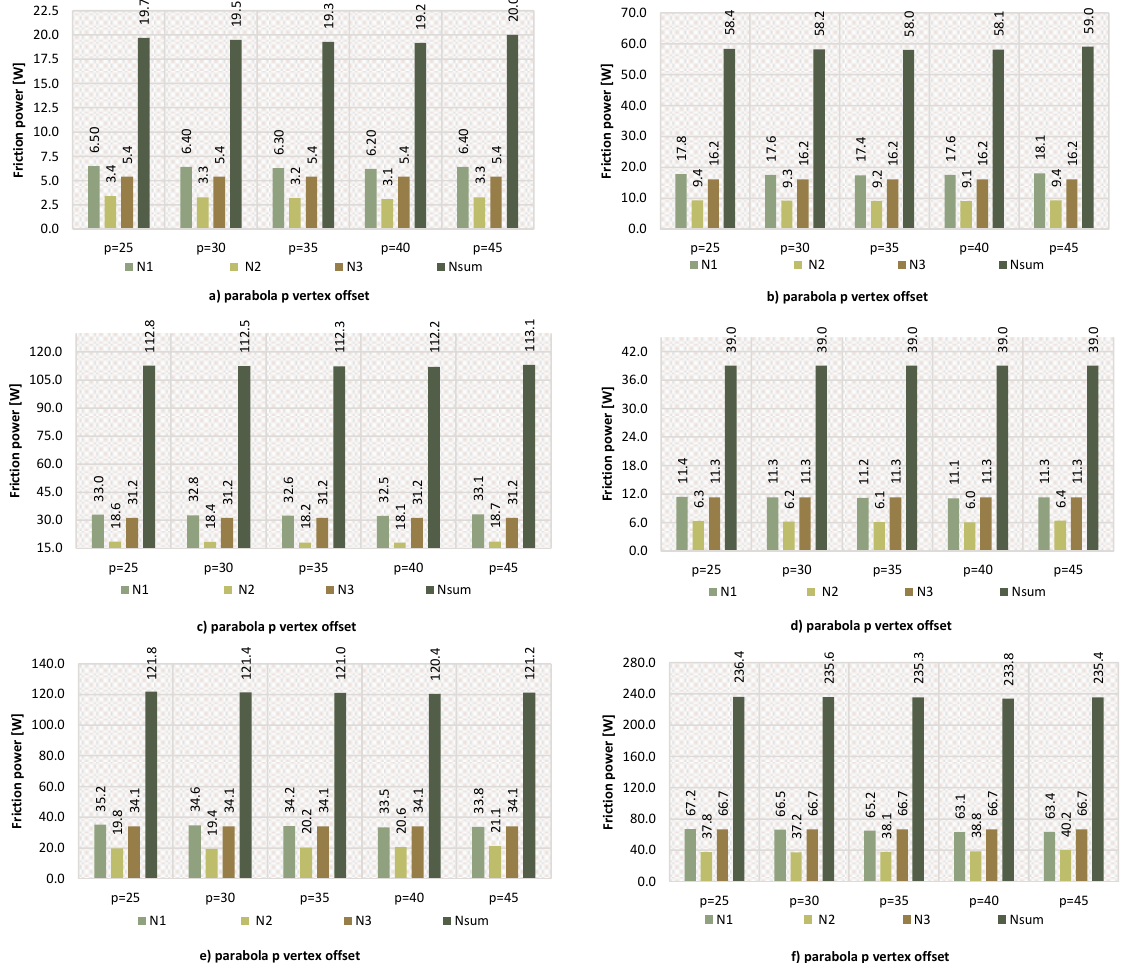
Fig. 2. Piston ring friction power for the engine velocity relative to the parabolic value of p j,k-1-2 , where: N 1 – Friction power of the upper sealing ring, N 2 – Friction power of the lower sealing ring, N 3 – Friction power of the scraper ring, N sum – Friction power of a piston ring set, a) for 1000 rpm, b) for 2000 rpm, c) 3000 rpm – dynamic viscosity of lubricating oil 0.0120 Pa ×s, d) for 1000 rpm, e) for 2000 rpm, f) 3000 rpm – dynamic viscosity of lubricating oil 0.0386